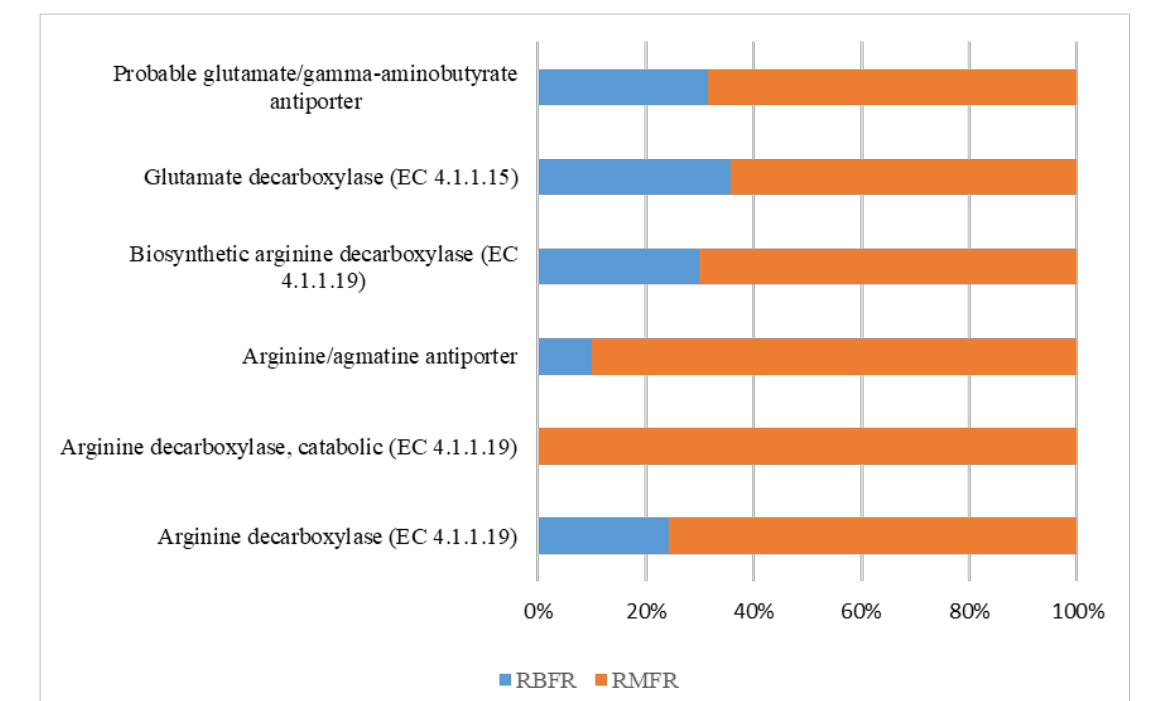
Figure 5. Gene abundances involved in the microbial-degradation pathways of stress response by the WGS Shotgun. Taxonomic assignments for the Royal Belum (SK, SP, and SR) and Raja Muda Musa (RM1, RM2, and RM3) metagenomes were performed using MgRast .